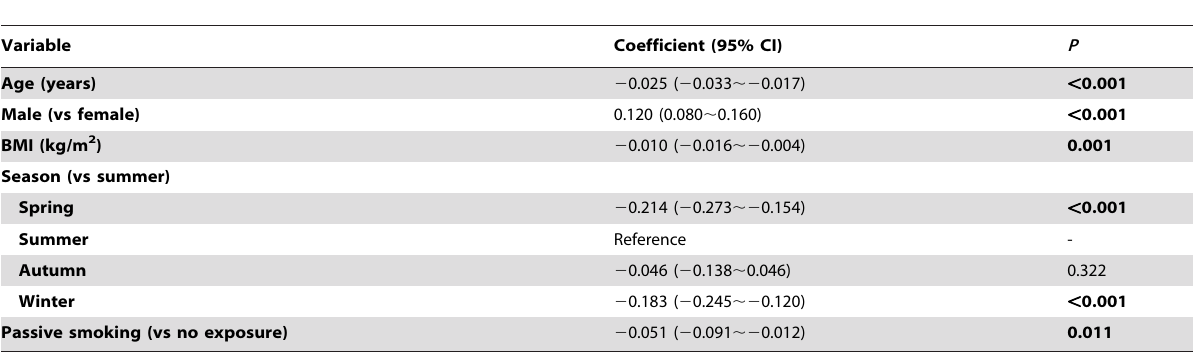
Table 2. Multivariate linear regression analyses for serum 25(OH)D levels.